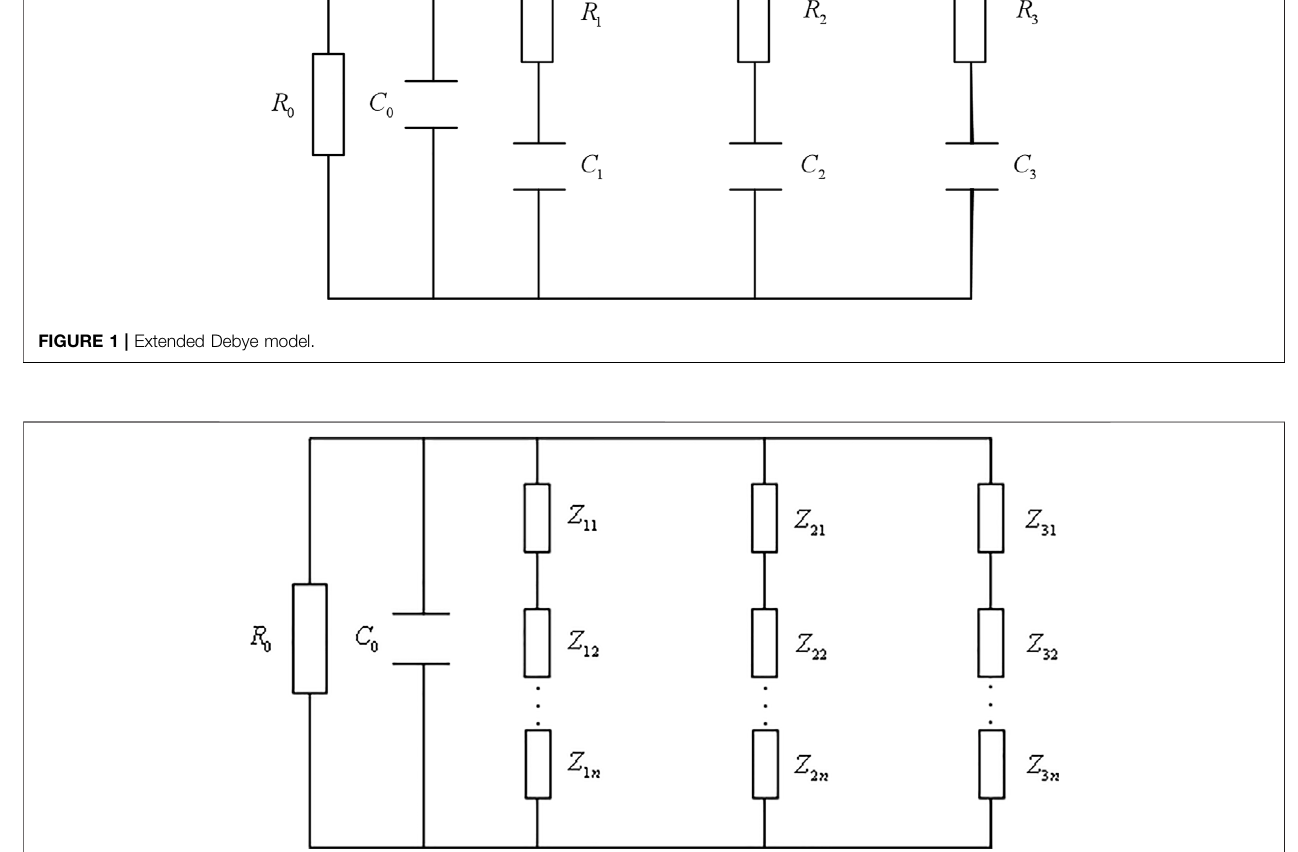
FIGURE 2 | Modi fi ed Debye